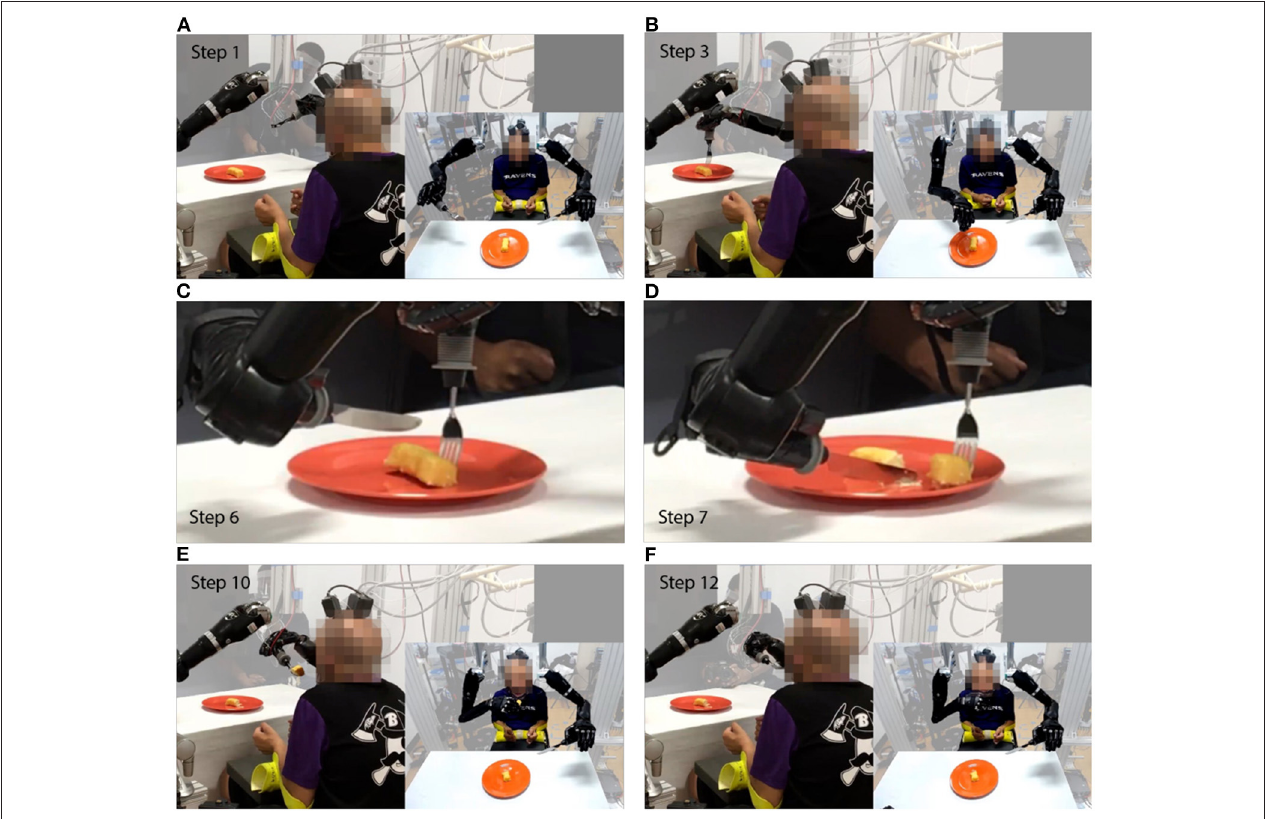
FIGURE 4 | Select screenshots of self-feeding task performance. The robot holds a fork in right hand and a knife in left hand. (A) Step 1: Participant initiates task by moving robot right hand forward. (B) Step 3: Participant repositions fork horizontally to align with desired piece of food. (C) Step 6: Participant repositions knife horizontally to select cut point. (D) Step 7: Participant moves knife down and fork back and right to cut food. (E) Step 10: Robot moves food to default position in front of participant’s mouth. (F) Step 12: Participant places food in